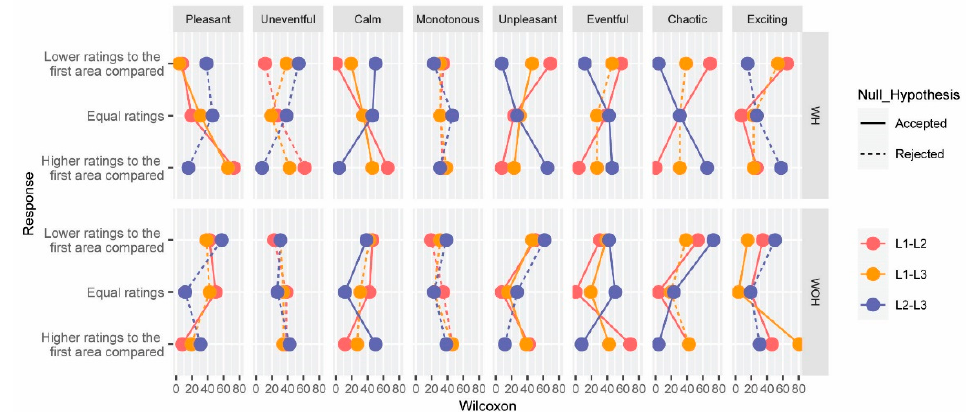
Figure 6. Wilcoxon signed-rank test results for each of the possible combinations of locations—L1–L2 (red), L1–L3 (green), and L2–L3 (blue)—for the eight SDS under study (pleasant, uneventful, calm, monotonous, unpleasant, uneventful, chaotic, and exciting). Results are split by the scenarios with (WH) and without the helicopter noise (WOH). Significant (continuous line) and non-significant differences (dashed line) between paired variables are also represented.